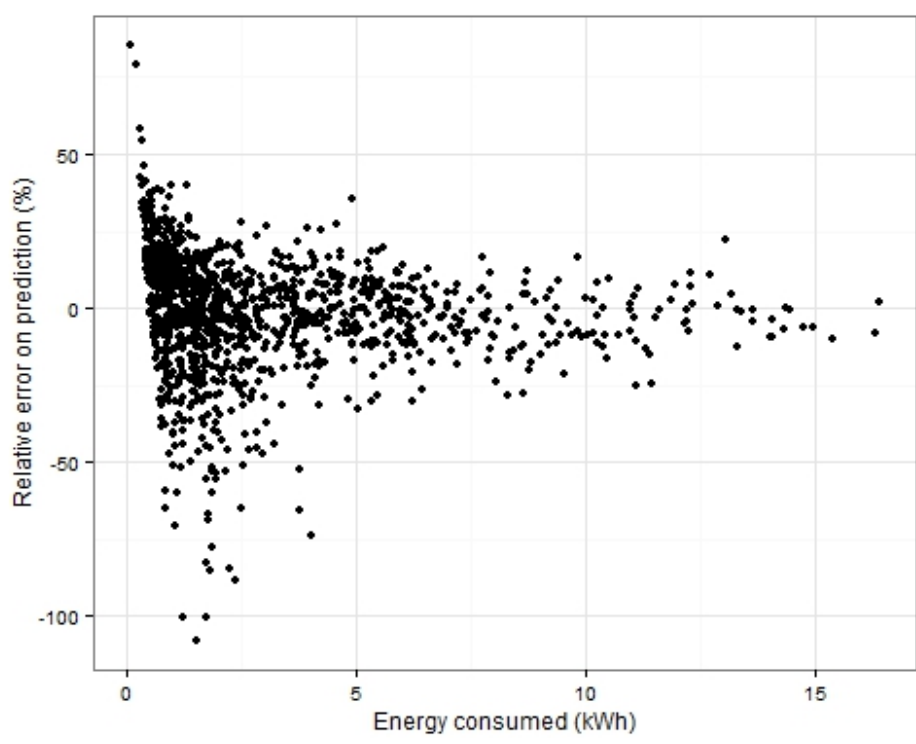
Figure 11. Relative error in the trips’ energy consumption predictions using the micro